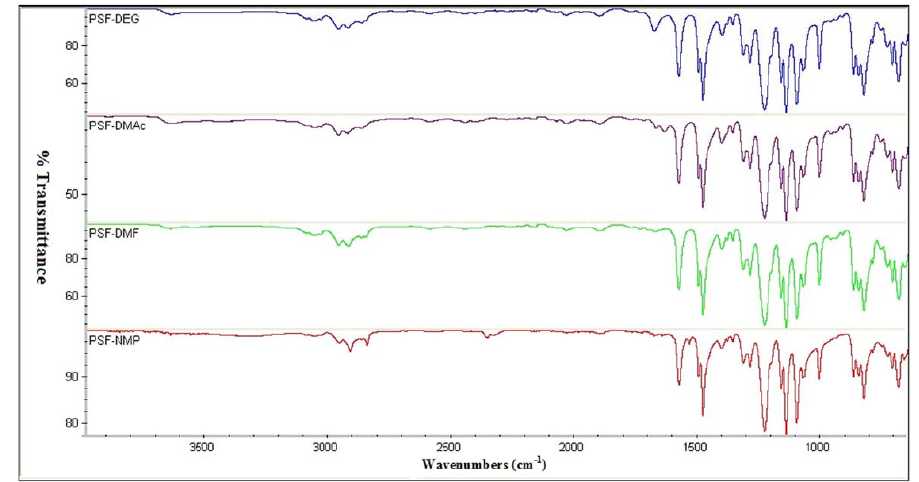
Figure 21. FTIR analysis indicating no significant change in the preparation of polysulfone (PSF) membrane using diethylene glycol (DEG), dimethylacetamide (DMAc), dimethylformamide (DMF), and n-methylpyrrolidone (NMP) as solvents [93]. Table 7. FTIR studies for characterization of polymeric membrane.